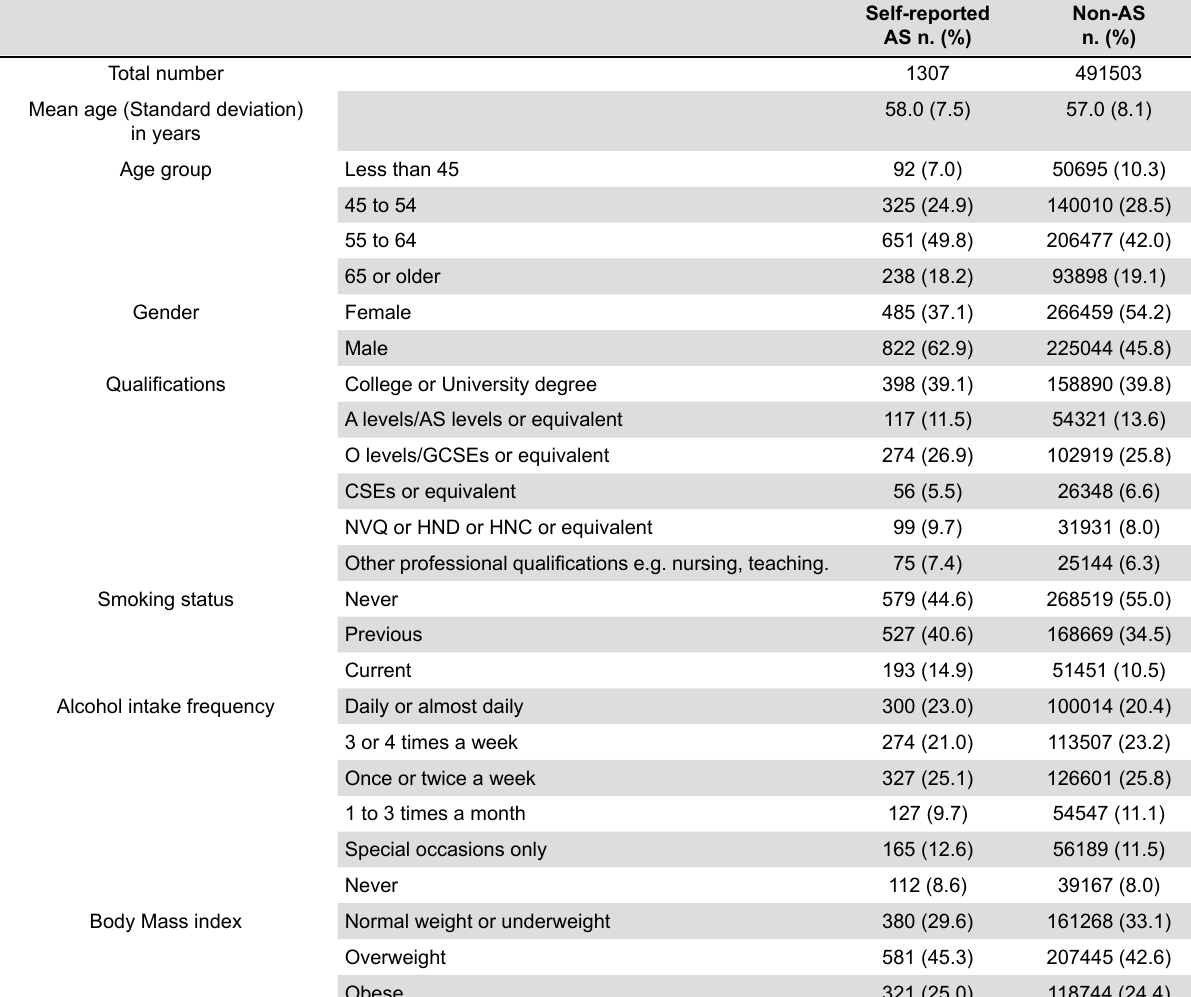
Table 1- Socioeconomic description of the self-reported ankylosing spondylitis (AS) and control groups, excluding self-reported rheumatic disease